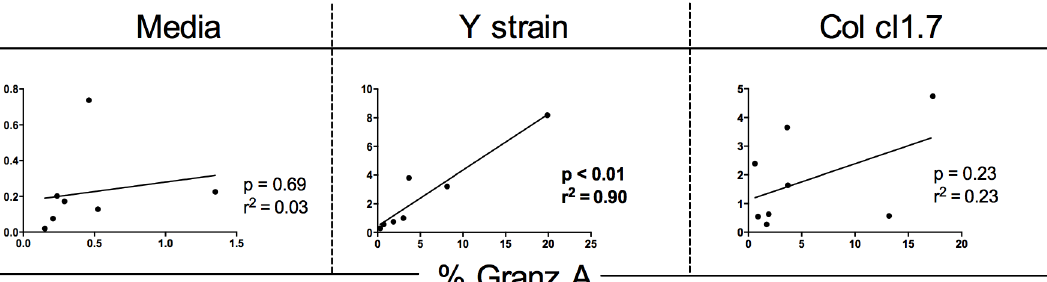
Fig 5. Correlation analysis of the expression of Granzyme A with the expression of TNF-alpha in CD8 T cells. Statistical significance ( p value) is indicated in each graph together with the r 2